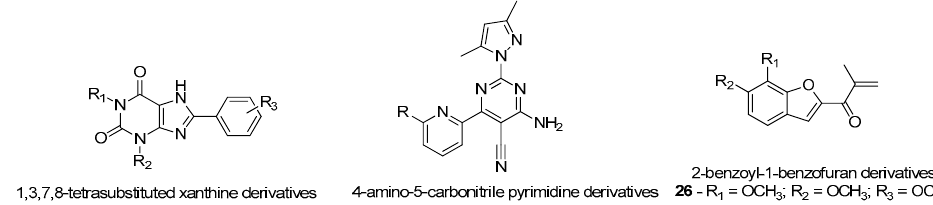
Figure 21. Structures of the studied adenosine receptor